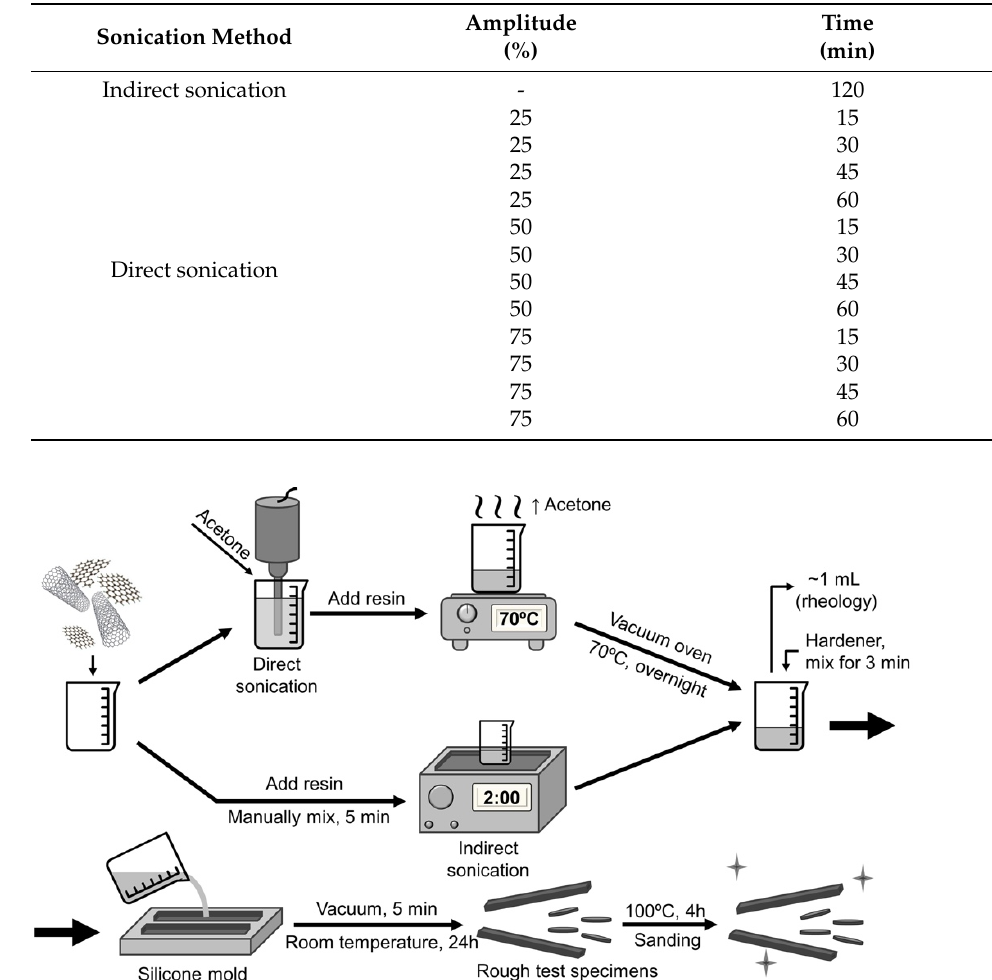
Figure 1. Simplified summary of the sample preparation